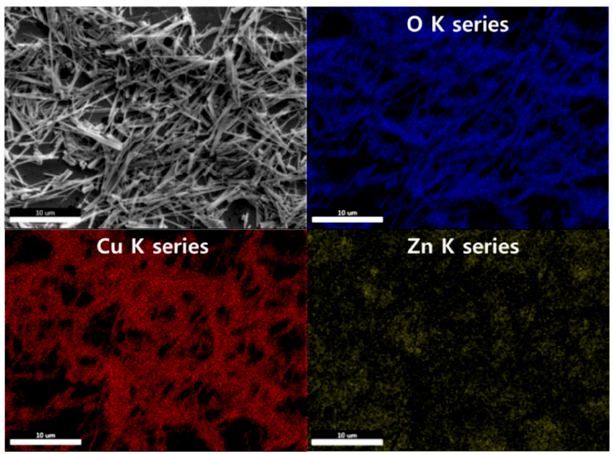
Figure 3. EDS mapping images of the 0.05 M CuO/ZnO gas sensor.